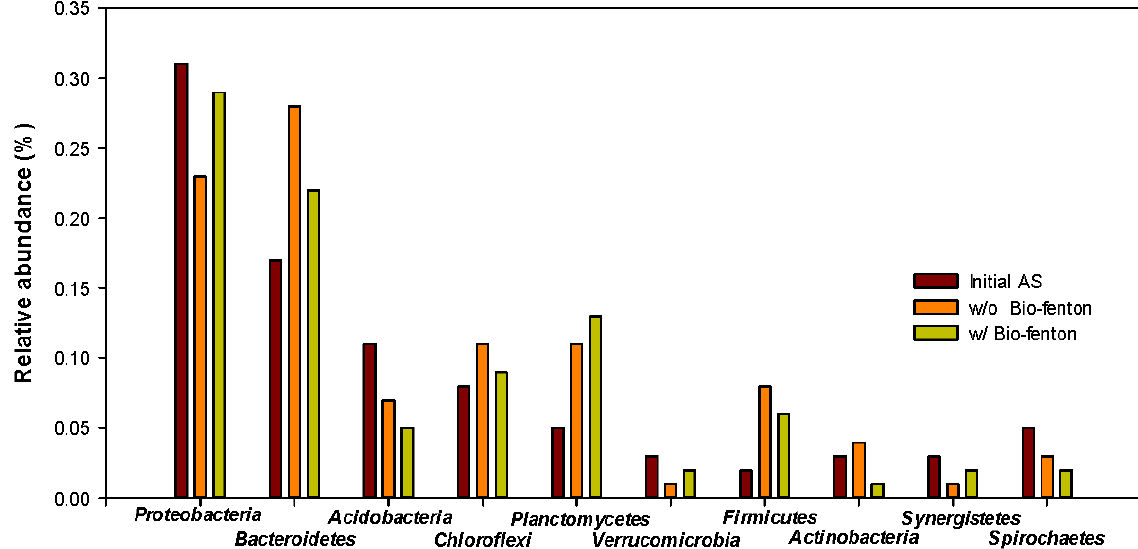
Figure 4. Microbial community structure in sludge samples.